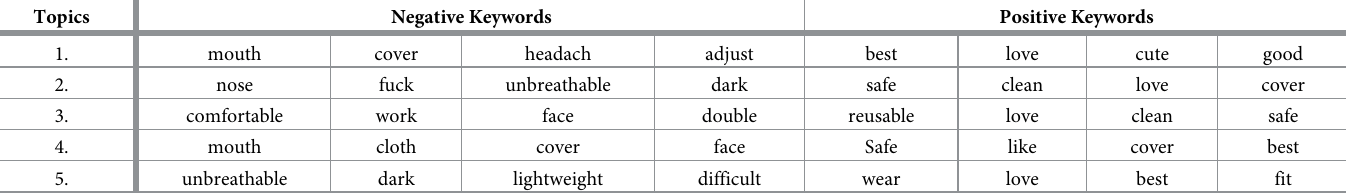
Table 9. Topics extracted from positive and negative tweets using